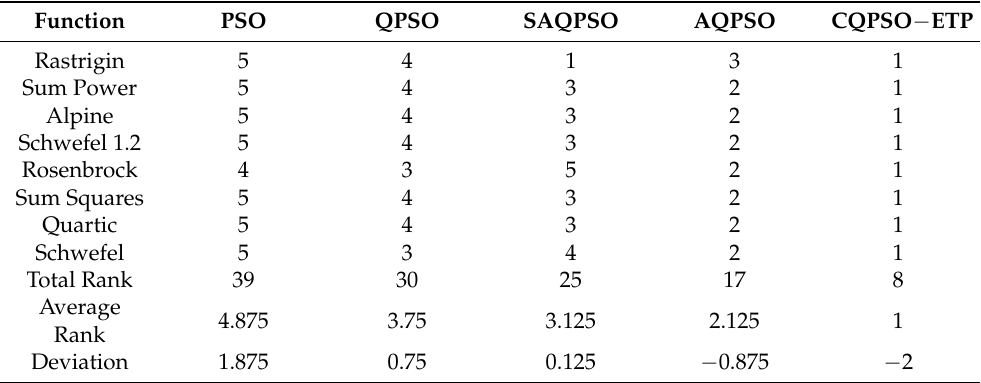
Table 6. Ranks of the average values for five comparative approaches (Mean) and computation of the Friedman test statistic ( D = 2).